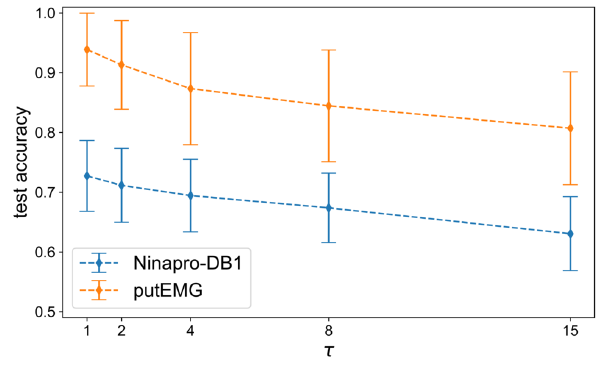
Figure A3. Average test accuracy of the AtzoriNet* for different sliding window steps τ